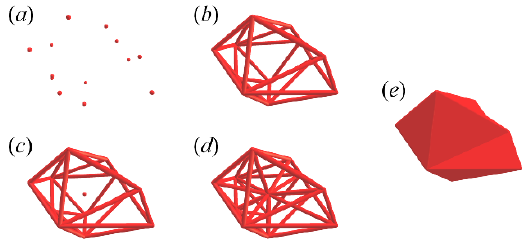
Fig. 1. Algorithm for constructing polyhedral rock particles in Yade. (a) : Generate a set of vertices; (b) form grid connections based on Delaunay triangulation; (c) place grid node at centroid; (d) form grid connections between vertices and centre grid node; (e) create